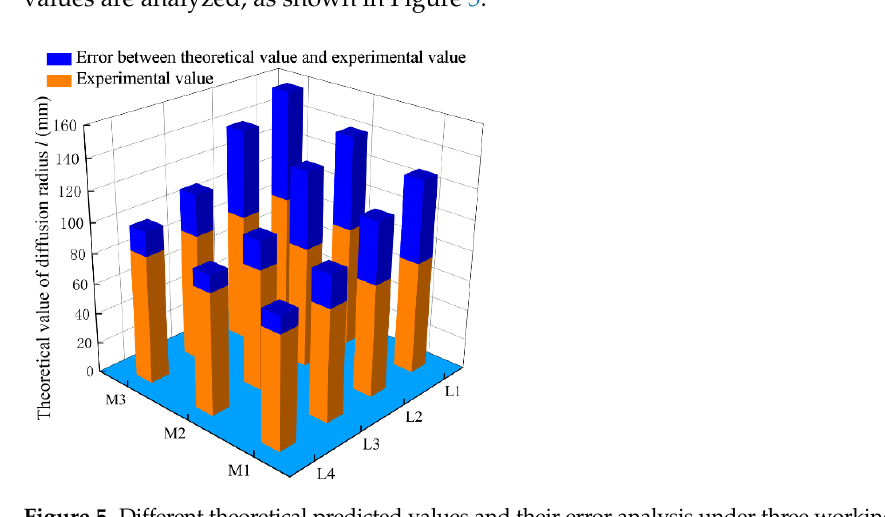
Figure 5. Different theoretical predicted values and their error analysis under three working conditions.